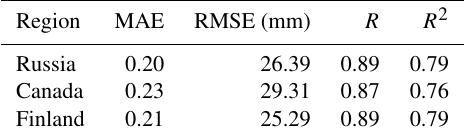
Table 3. Error list for the station data and RRM SWE product in different